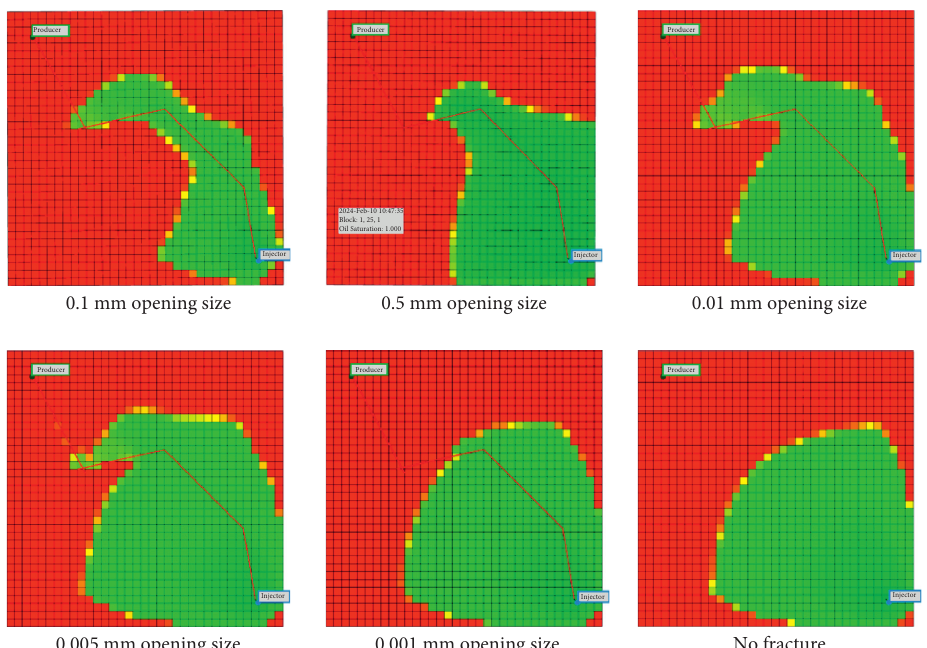
Figure 10: Oil saturation distribution of water flooding in reservoirs with different fracture openings. (a) 0.1mm opening size. (b) 0.5mm opening size. (c) 0.01 mm opening size. (d) 0.005mm opening size. (e) 0.001mm opening size. (f) No fracture.